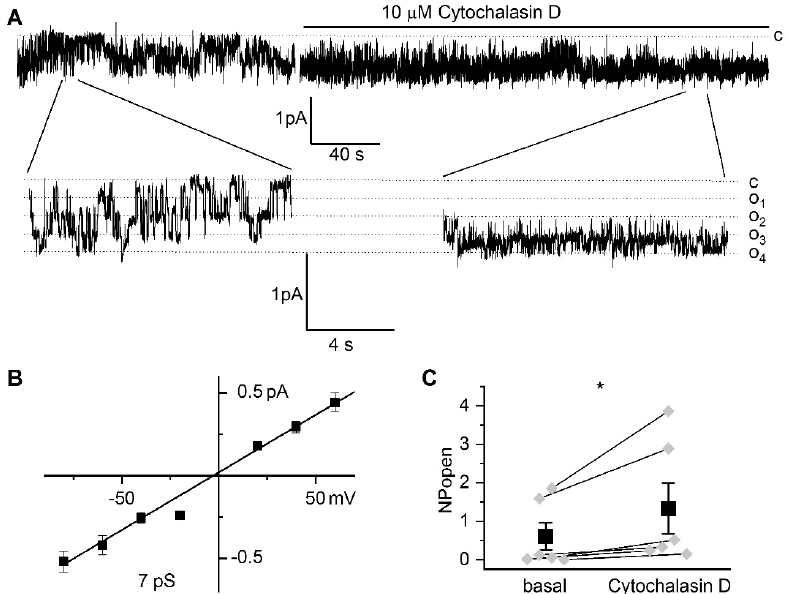
Figure 4. Application of cytochalasin D to podocytes induces activation of a native channel with 7 pS conductance. ( A ) Representative trace of basal channel activity before and after 10 µM cytochalasin D at a holding potential of –40 mV. Expanded fragments are shown below. Closed (c) and open (o i ) states are indicated. ( B ) Current-voltage relationship of channels with estimated conductance 7.0 ± 0.2 pS. ( C ) Summary graph of the effect of 10 µM cytochalasin D on 7 pS channel activity (NP o ). Wilcoxon nonparametric test for paired samples; * = p < 0.05 level.